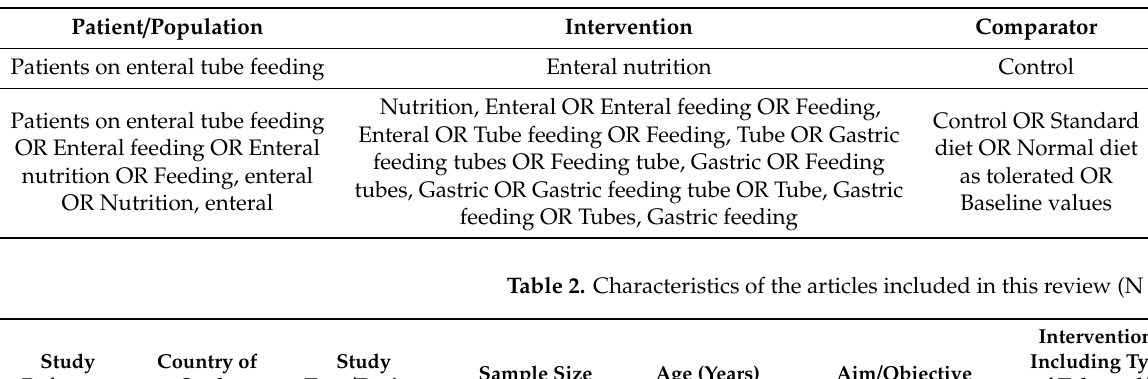
Table 1. Search Terms and Search Strategy.